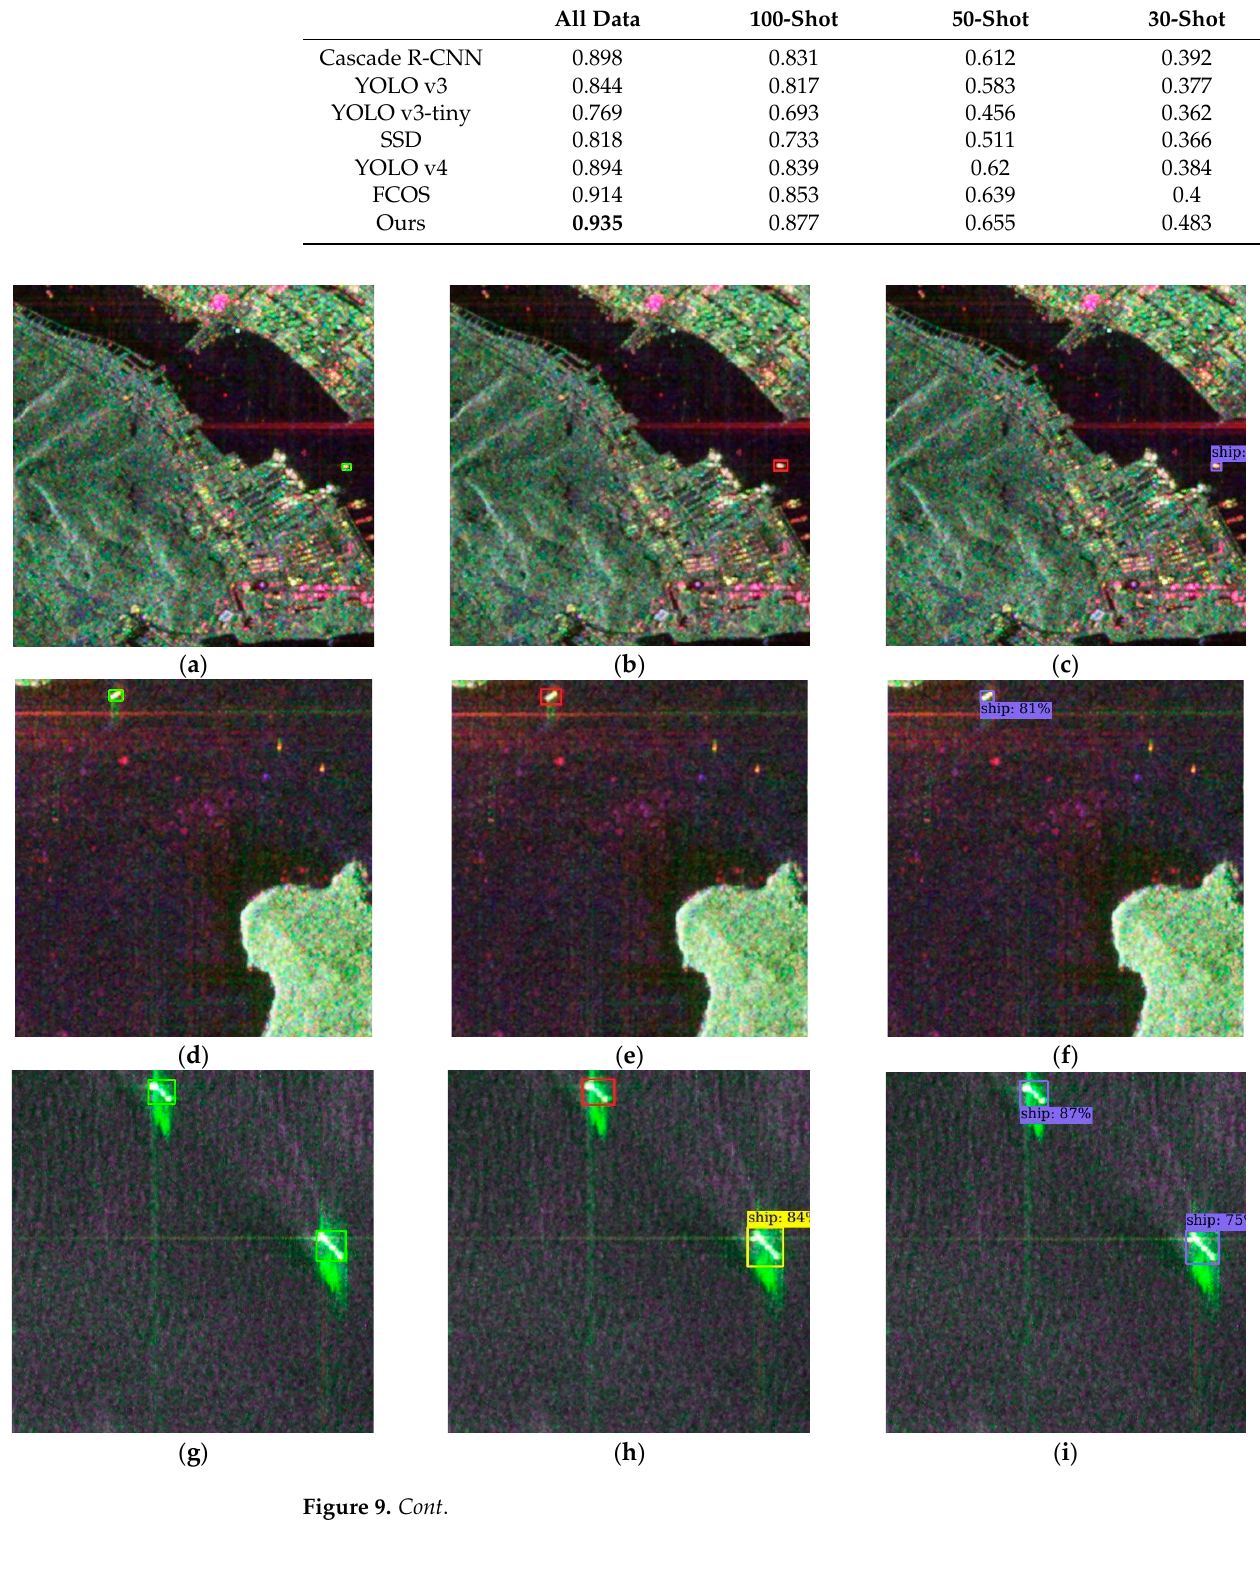
Table 4. Ship detection results (AP) of different detectors.